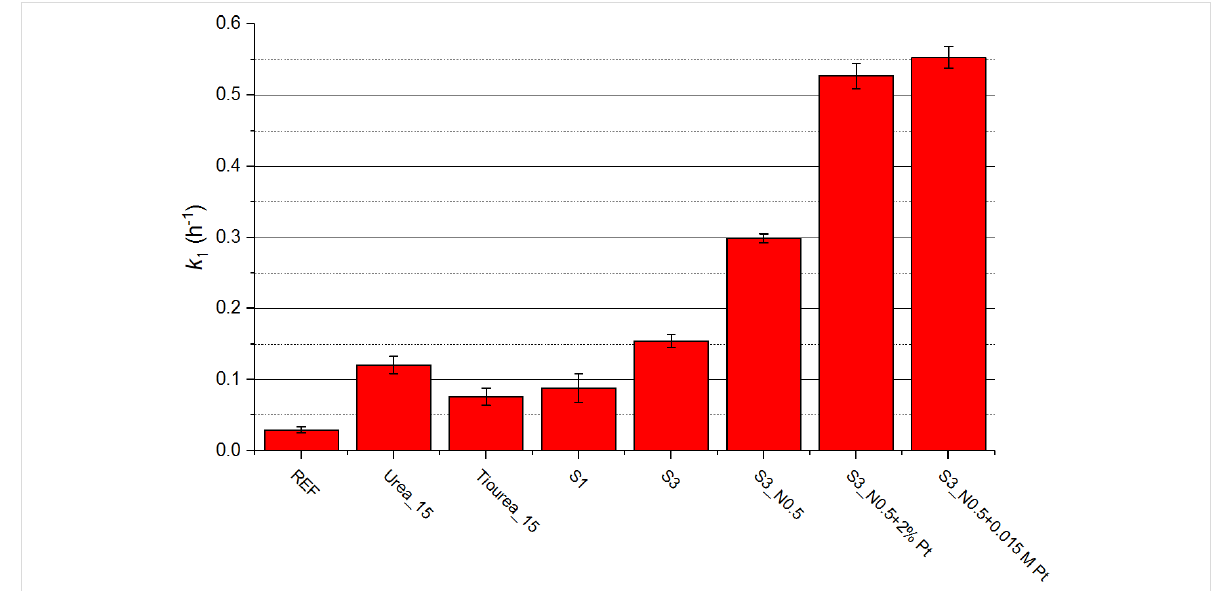
Figure 8: First-order rate constant for plasmocorinth B degradation for selected photocatalysts synthesized in this work.